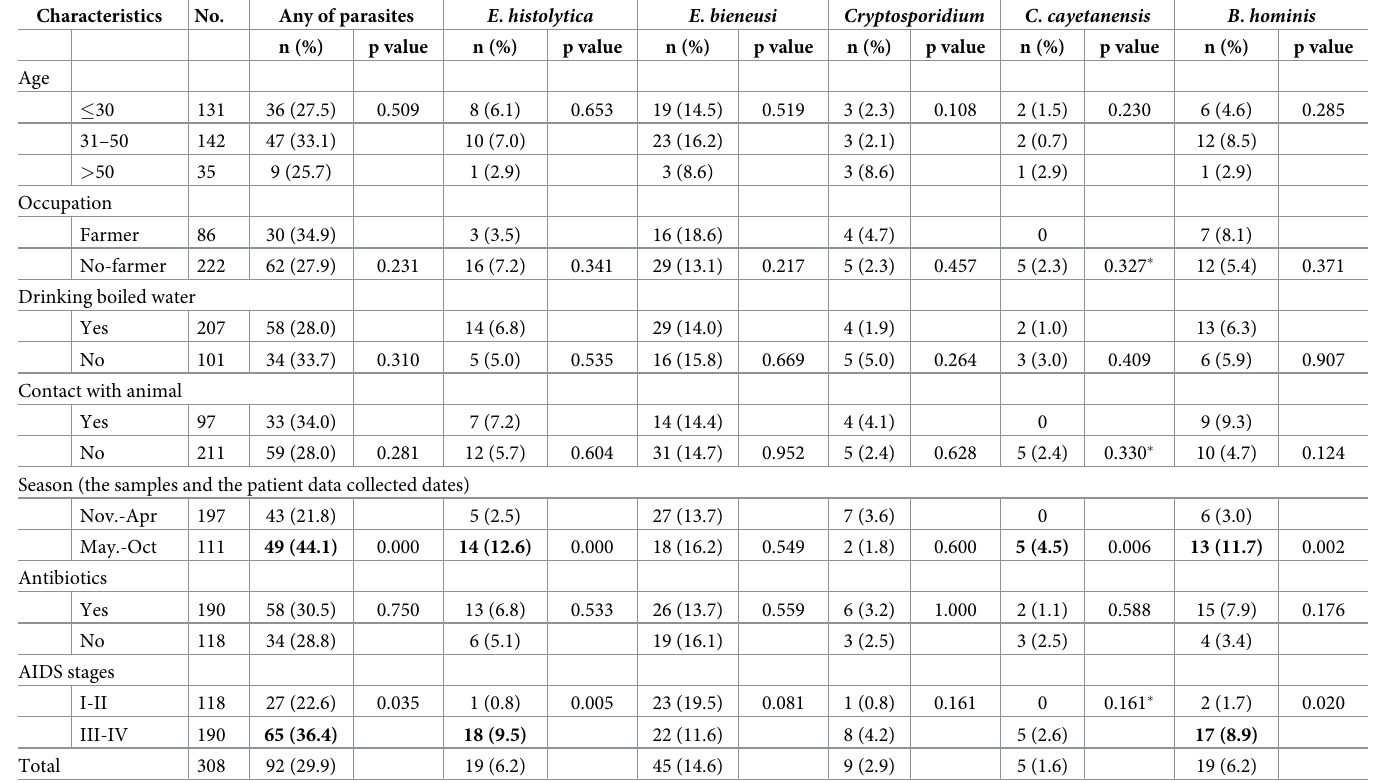
Table 2. Risk factors associated with enteric parasite infection in MSM HIV-positive